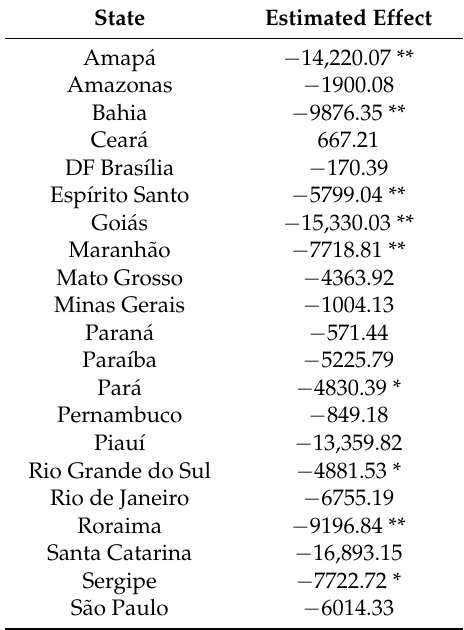
Table 7. Fixed-effects for Brazilian states (dependent variable: Total raised value per project). State Estimated Effect Amap